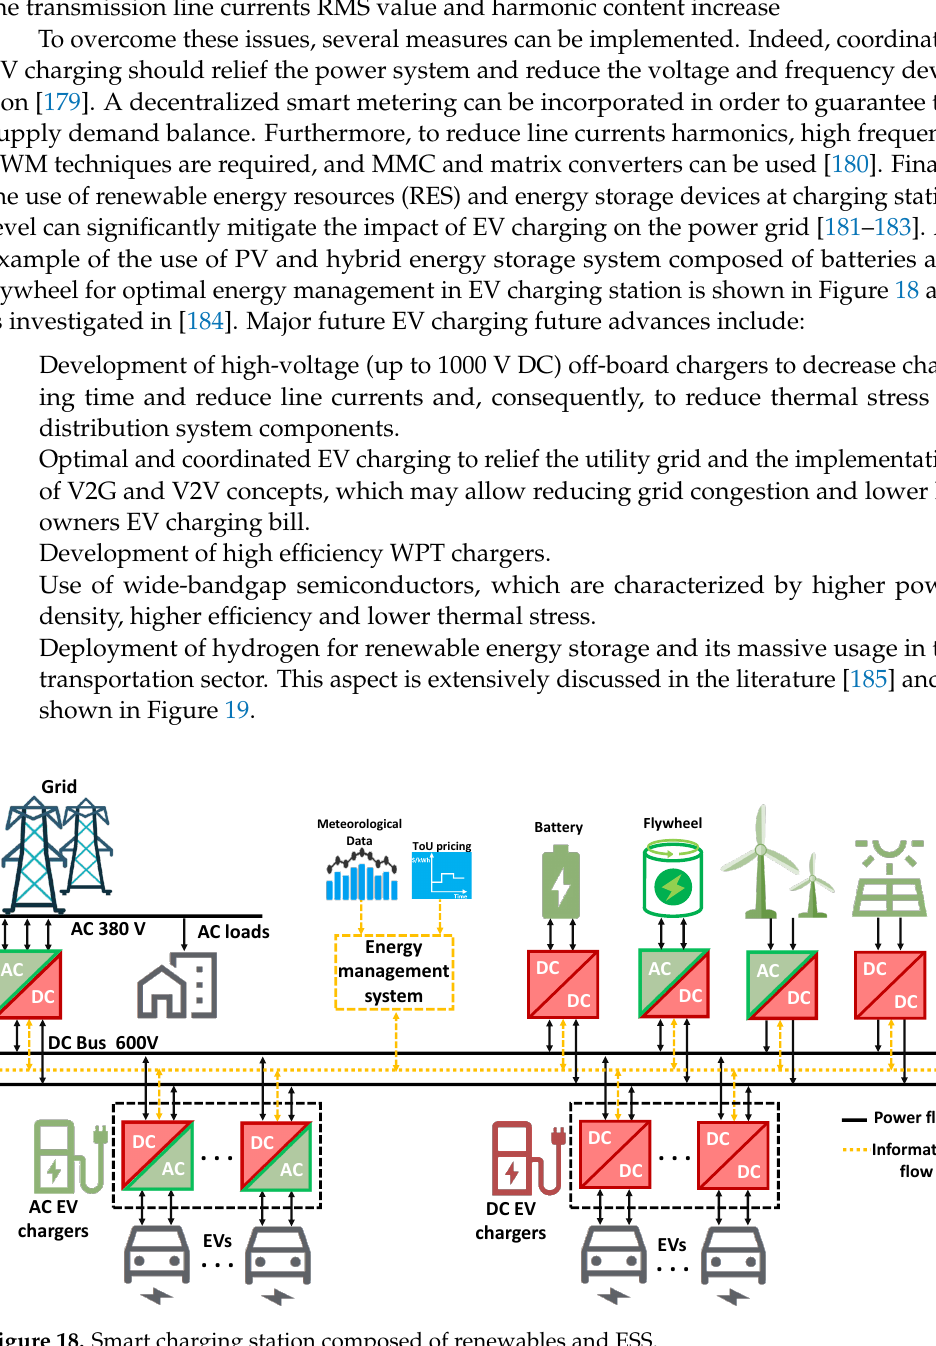
Figure 18. Smart charging station composed of renewables and